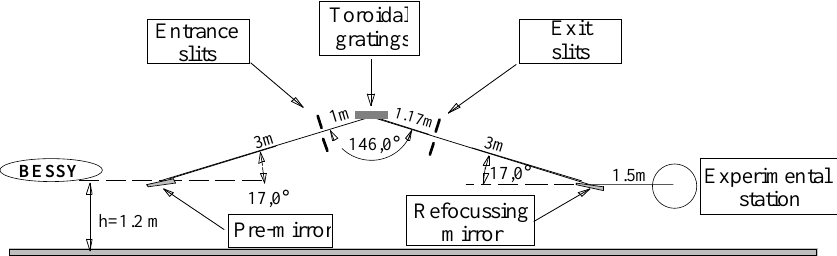
FIG. 1. TGM7 optical